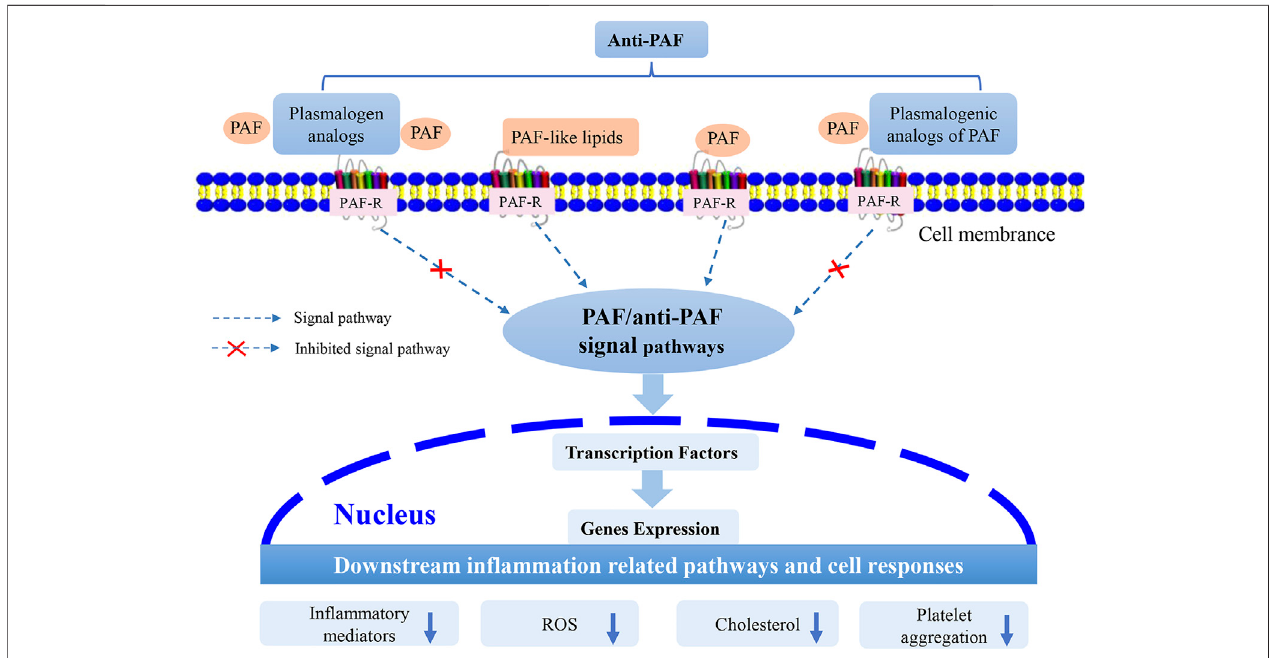
FIGURE4| Suggestedmodesofactionofplasmalogen,plasmalogenanalogsandplasmalogenicanalogsofPAFasPAFantagonists( i.e., anti-PAF).Plasmalogen and its analogs, aswell as plasmalogenic analogs ofPAF, may compete withthe other PAF lipid family (PAF and PAF-like lipids) to bindto the membrane receptor, PAF- R. Consequently, they may modulate the PAF/anti-PAF signaling pathways, such as NF- κ B and MAPK, and further inhibit the expression of transcription factors and genes. The potential PAF antagonists (anti-PAF) may modulate the downstream in fl ammation-mediated pathways and other cellular responses.